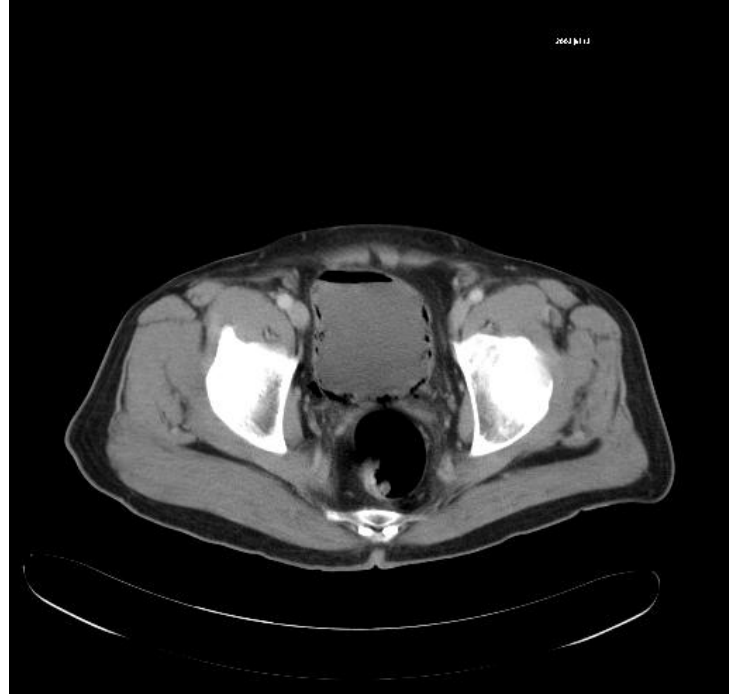
FIGURE 2 . Intramural and intraluminal gas in the urinary